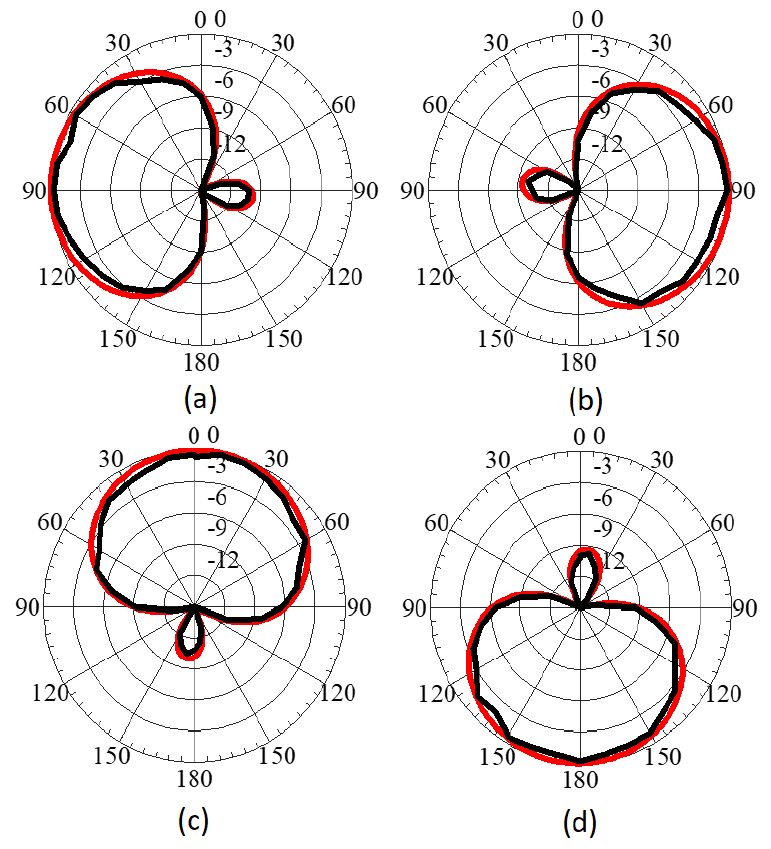
Figure 8. Simulated and measured radiation patterns of the proposed CubeSat MIMO antenna at 450 MHz: ( a ) Ant-1, ( b ) Ant-2, ( c ) Ant-3, ( d ) Ant-4. The red lines show simulated data, while the black lines denote measured data.